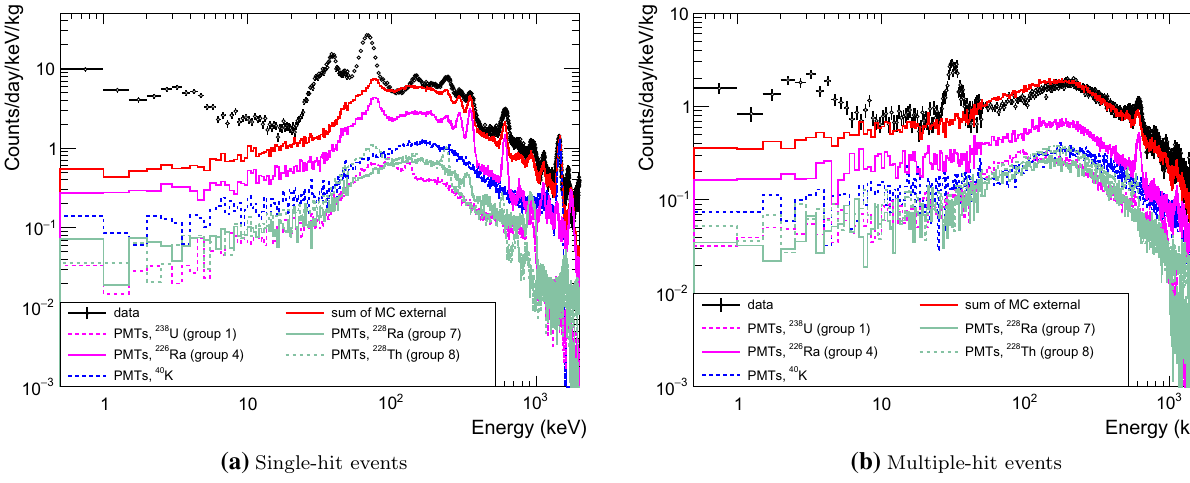
Fig. 3 Simulated background spectra of 238 U, 232 Th, and 40 K from external sources inside the copper